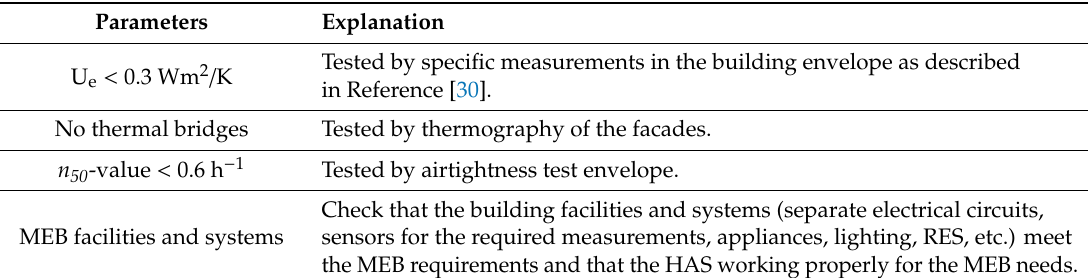
Table 4. MEB refurbishment works management requirements.